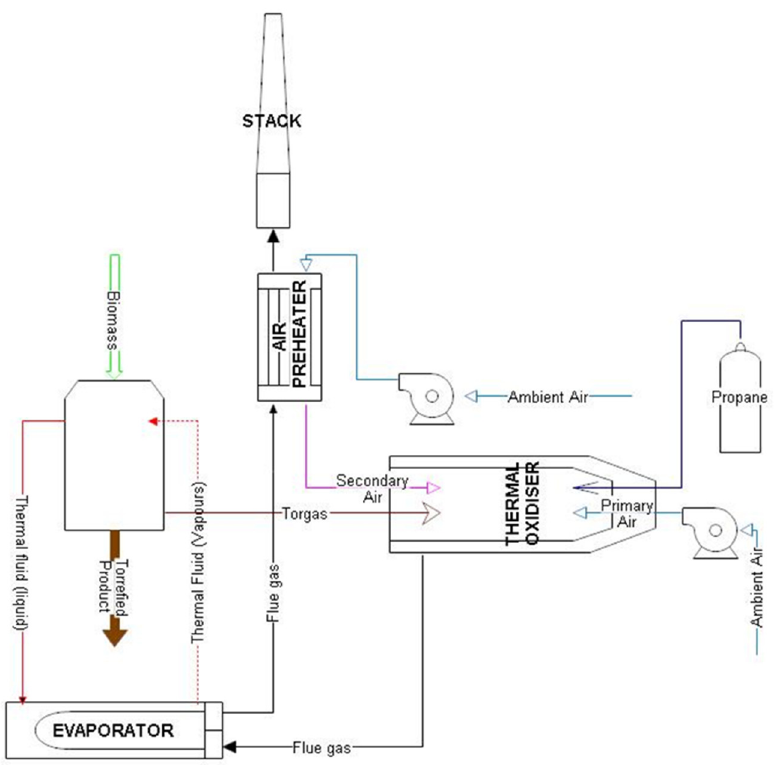
Figure 1. Diagram of the Pilot Torrefaction Installation.